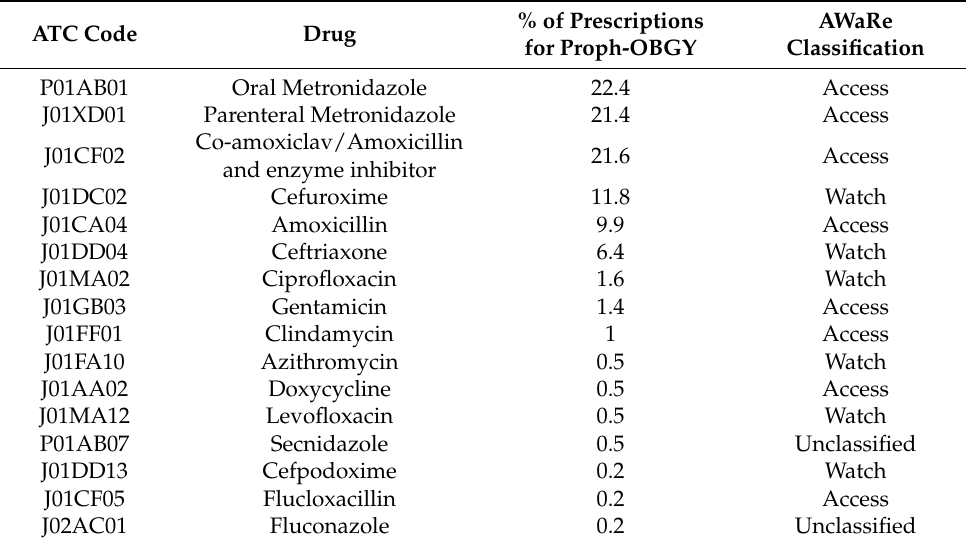
Table 5. Antimicrobials prescribed for prophylactic OBGY purposes in Ghana (% of total) and AWaRe